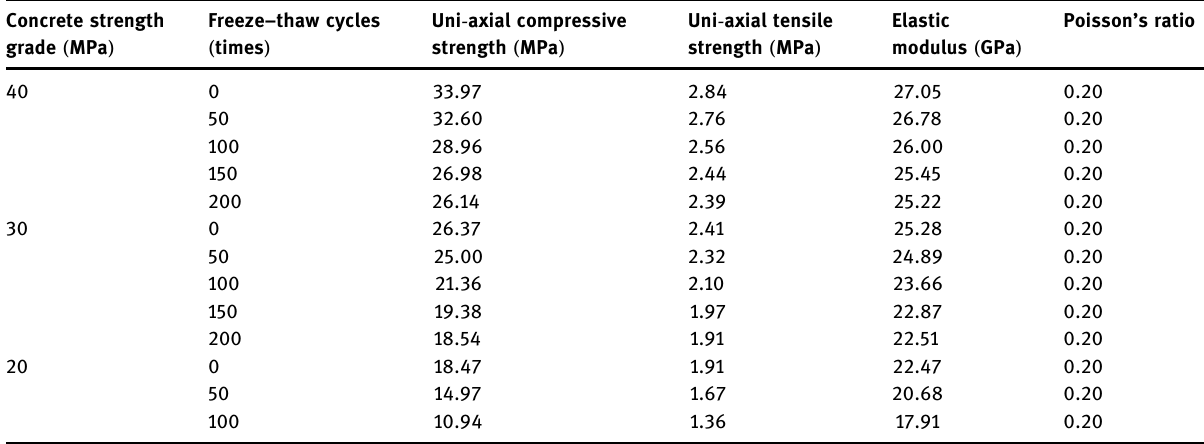
Table 1: Basic performance indicators of recycled aggregate concrete Concrete strength